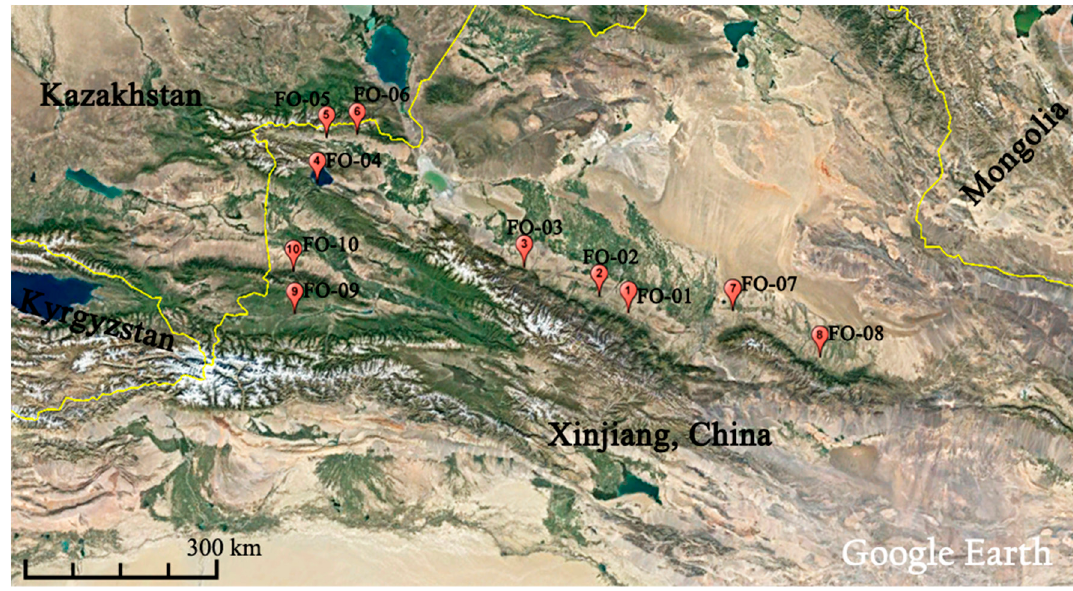
Figure 5. Geographical locations of analyzed populations of Festuca ovina in Xinjiang, China.